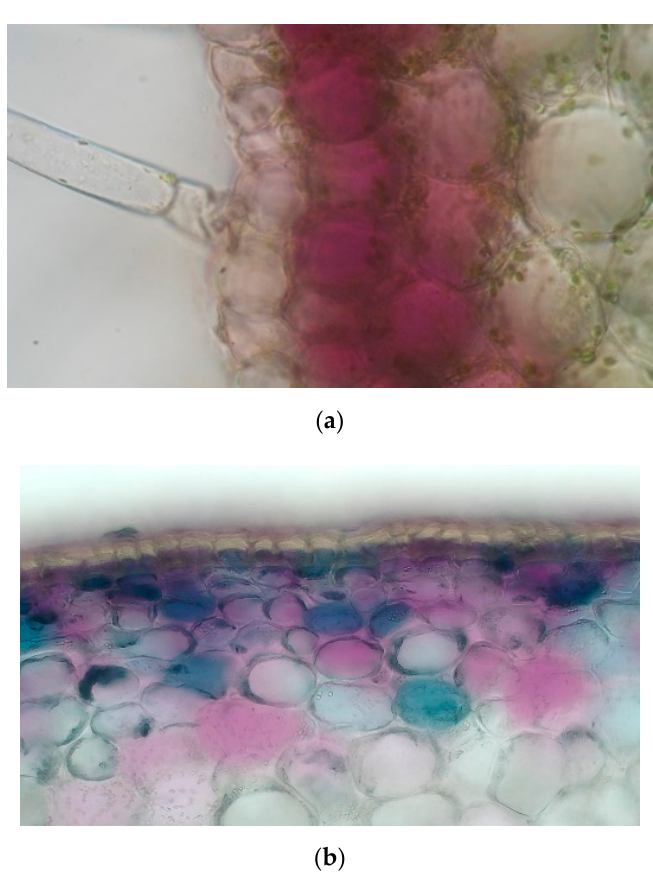
Figure 1. Cross-section of the hypocotyl ( a ) and berry ( b ) of ‘Pim. Ney.’.